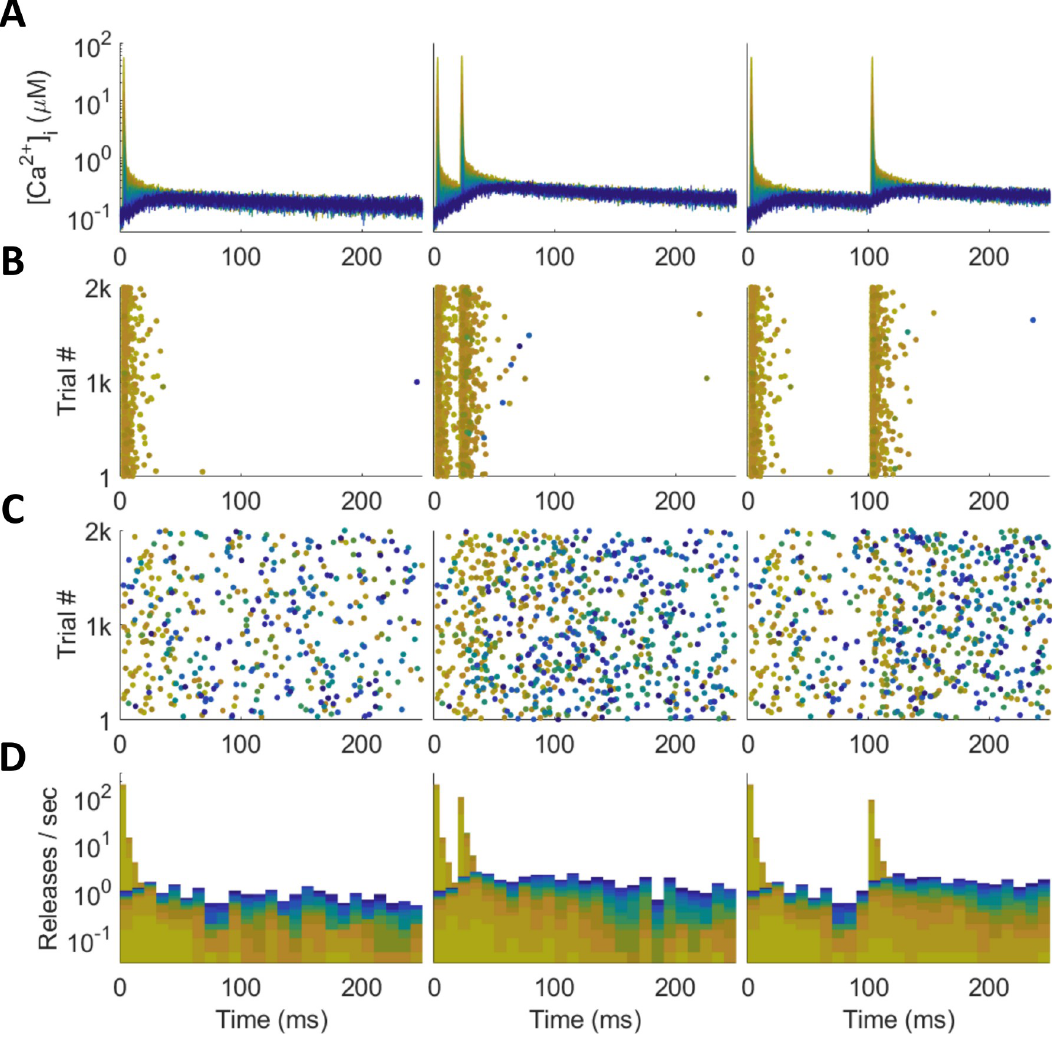
Fig 4. Synchronous and Asynchronous Release in MCell. Color indicates distance from VDCC source, with yellow representing a nearby Ca 2+ sensor and dark blue a distant one (as in Fig 2A and 2B). Action-potential-like stimulus delivered at 0 ms (left), followed by another at 20 ms (center) and 100 ms (right). (A) Spike-evoked Ca 2+ traces that drive release. (B) Synchronous release raster. (C) Asynchronous release raster. (D) Synchronous (tall, thin bars) and asynchronous (short, wide bars) release stacked histogram. Most synchronous releases happen close to the Ca 2+ source; asynchronous releases distributed across all distances.